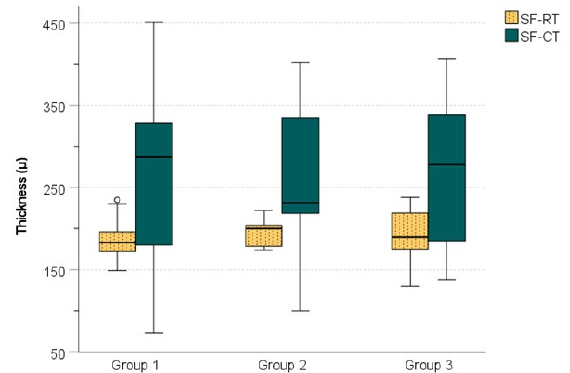
Figure 2. Subfoveal retinal thickness (SF-RT) and subfoveal choroidal thickness (SF-CT) in the three studied groups.